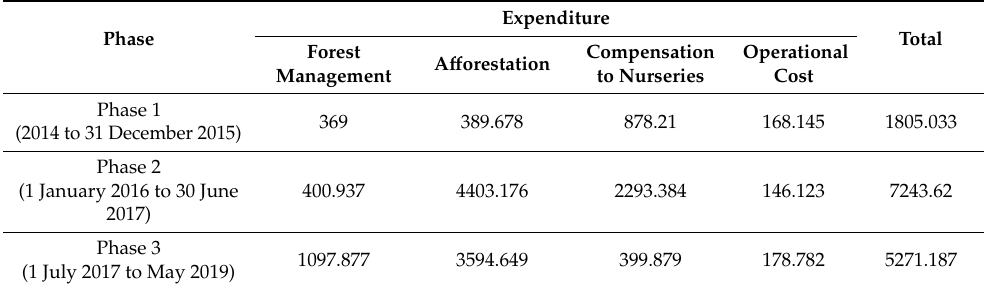
Table 1. Total expenditures involved in the implementation of the Billion Trees A ff orestation Project (BTAP) between 2014 and May 2019 (in million